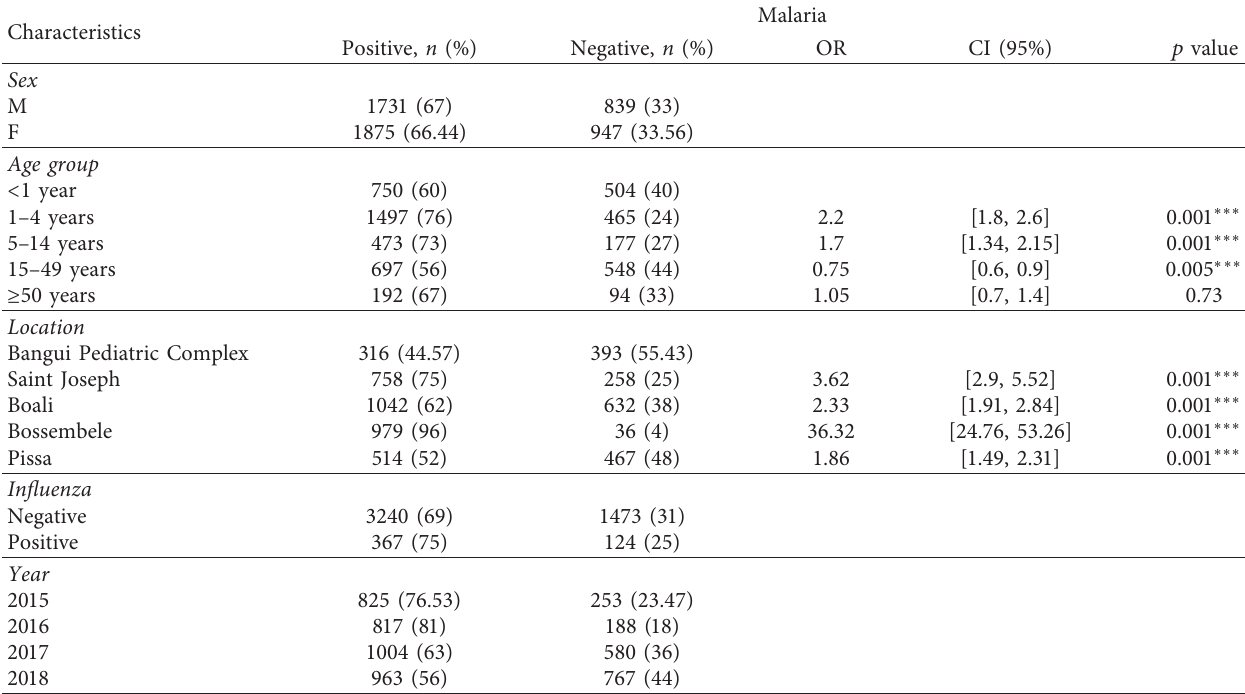
Table 1: Distribution of malaria infection according to demographic characteristics, Central African Republic, 2015–2018.